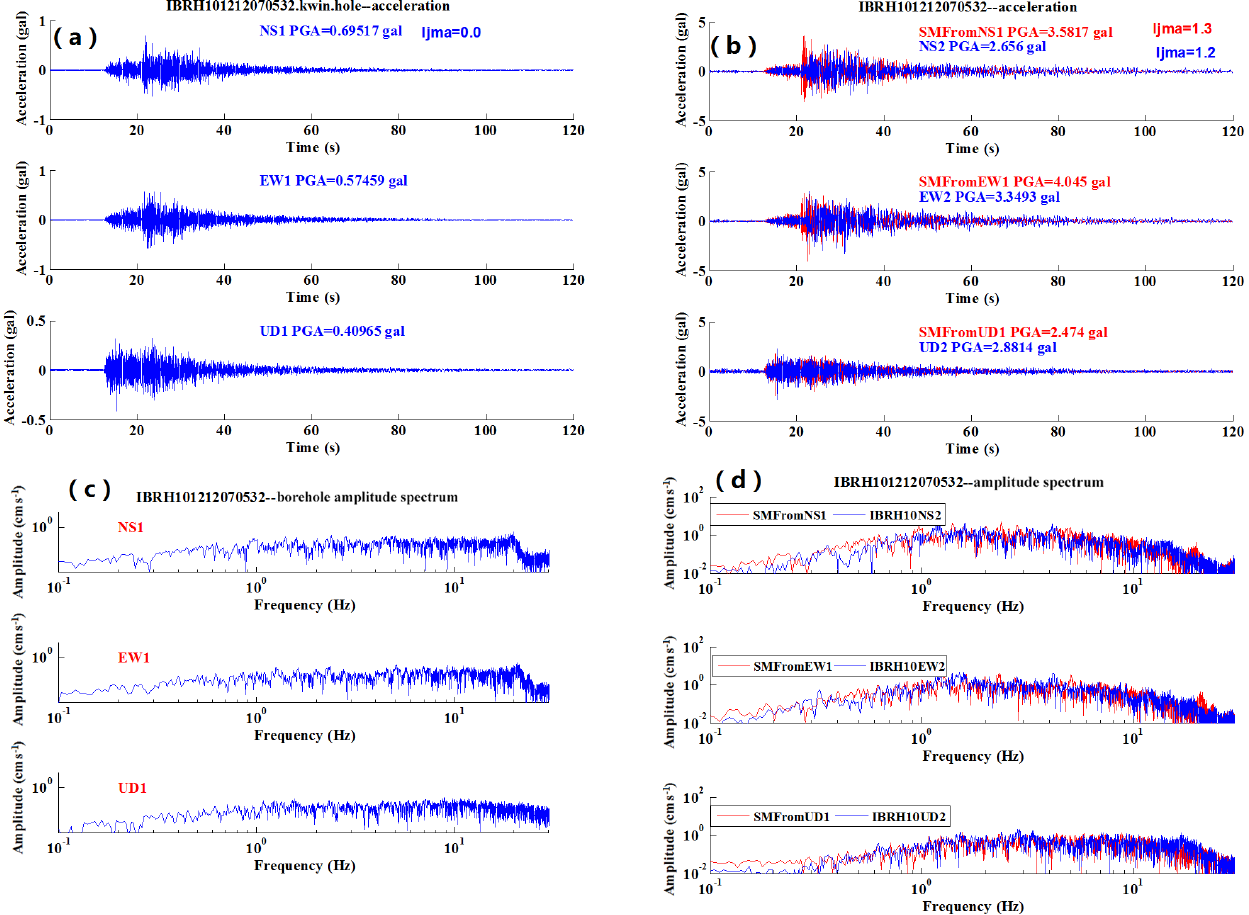
Figure 7. An example of the results of simulation for IBRH101212070532: (a) the observed acceleration at the borehole, (b) the observed surface acceleration waveform (blue) compared with the simulated one (red), (c) the spectra of the observed borehole record, and (d) the spectra of the observed surface record (blue) compared with the simulated one (red). Table 4. Information for M 5 . 1 earthquake (IBRH10 and IBRH19 for 201104140735). PGA (gal) PGA amp. I jma IBRH19 IBRH10 Amp. (IBRH10 / IBRH19) IBRH19 IBRH10 Res. (obs. − sim.) Comp. Obs. Obs. Sim. Obs. Sim. Obs. Obs.